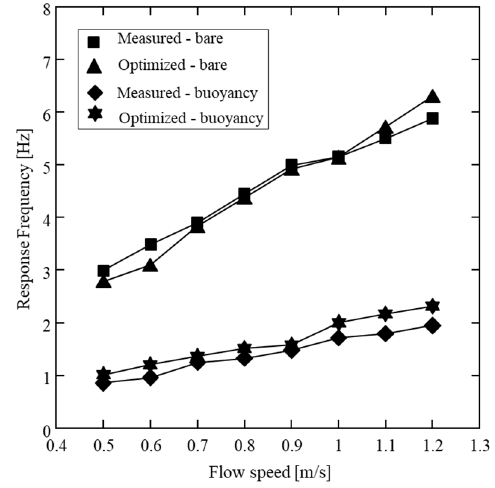
Figure 13. Comparison between the measured and predicted response frequencies for the 2/2 configuration for flow speed between 0.5–1.2 m/s.